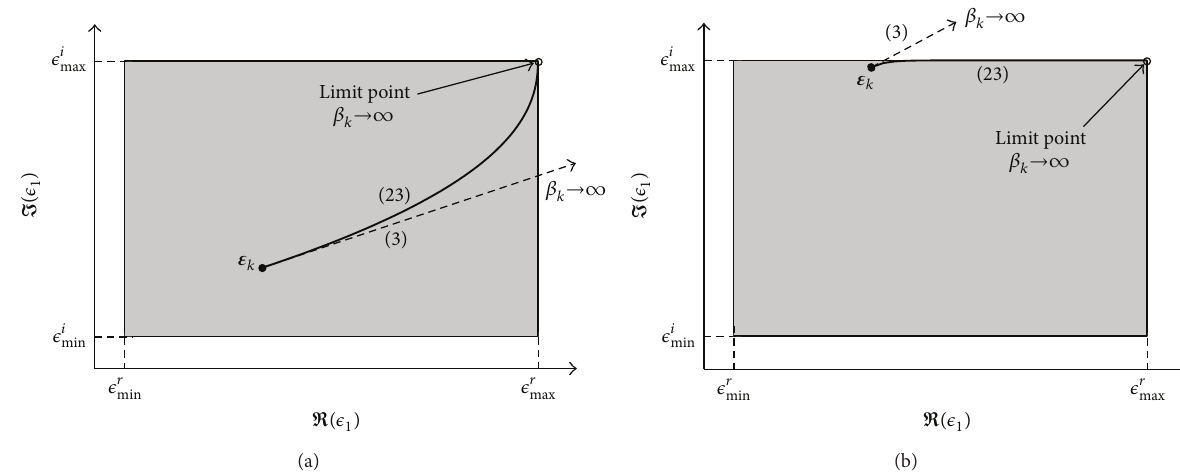
Figure 3: Illustration of the constrained line search path: (a) the starting point 𝜀 𝑘 lies far from the boundaries of the optimization domain, such that the new search path from (23) coincides with the original path from (3) up to large 𝛽 𝑘 ; (b) the starting point 𝜀 𝑘 lies close to a boundary of the optimization domain, such that the new search path from (23) starts running along the projection of (3) on this boundary already for small 𝛽 𝑘